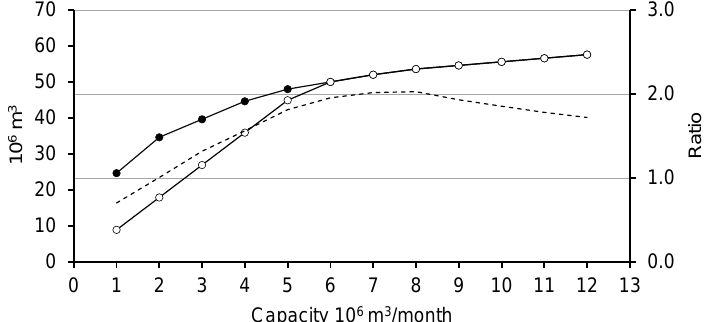
Figure 9. Total recharged volumes (closed circles), total recovered volumes (open circles), and ratio of levelised supply costs to recovered water value (dashed line) for the July 2009 to January 2020 simulation using historical water trading prices for a range of recharge capacities for the Macquarie River near Dubbo.